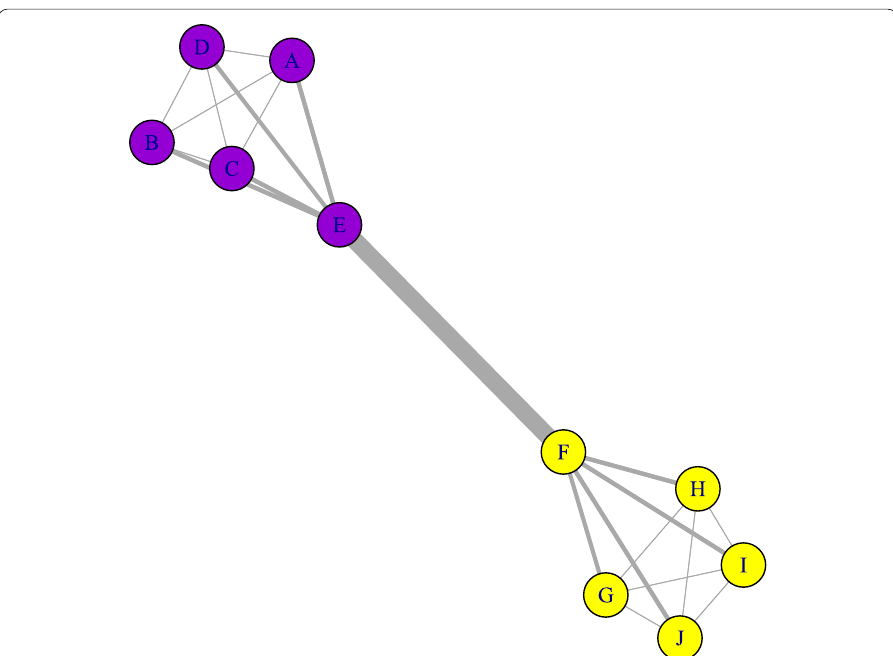
Fig. 2 Simple network demonstrating how the edge-betweenness algorithm works. Edge widths in this network are proportional to their betweenness scores. The edge between node E and F is removed first, splitting the network into two groups. The vertex color shows the communities identified by the edge-betweenness